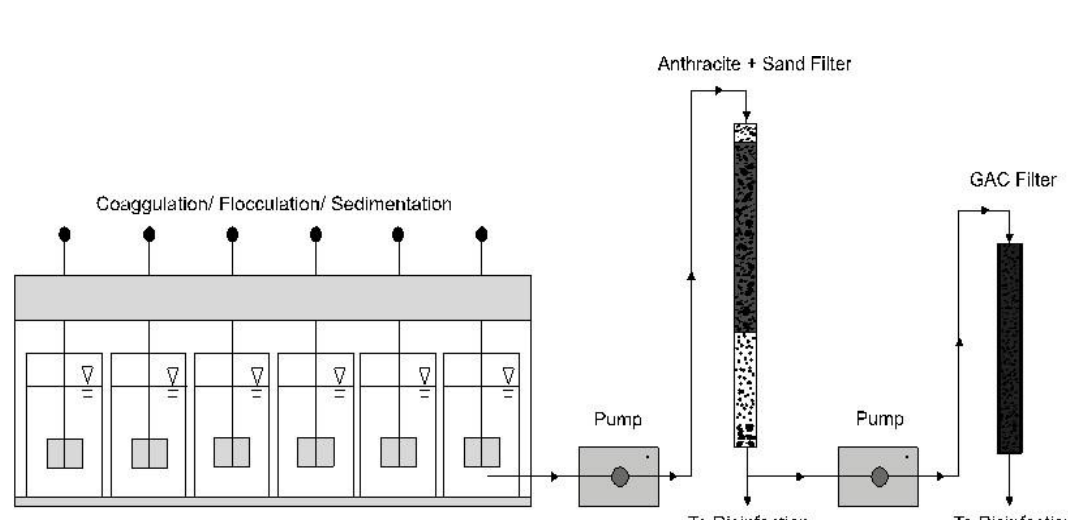
Figure 2. Flow-scheme of bench-top water treatment system.